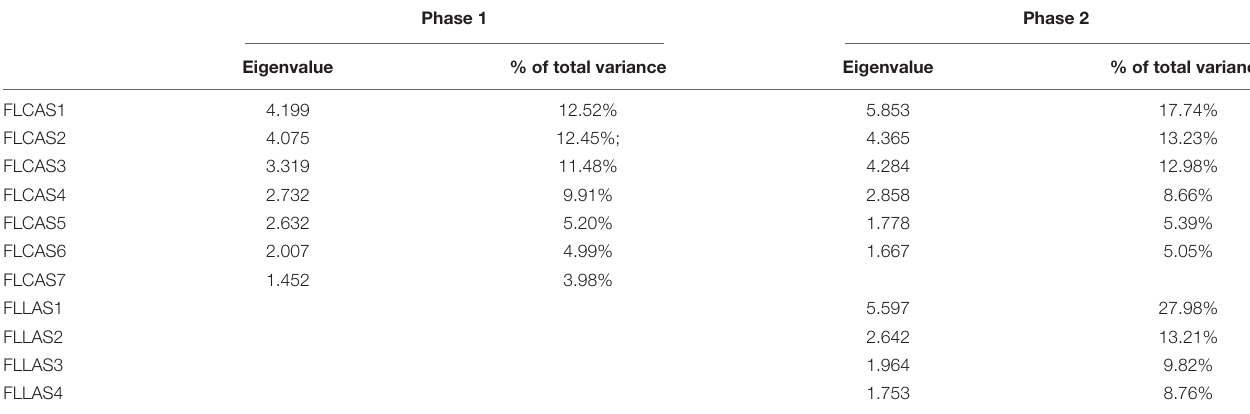
TABLE A1 | Eigenvalues and explained variances of FLCAS and FLLAS factors.